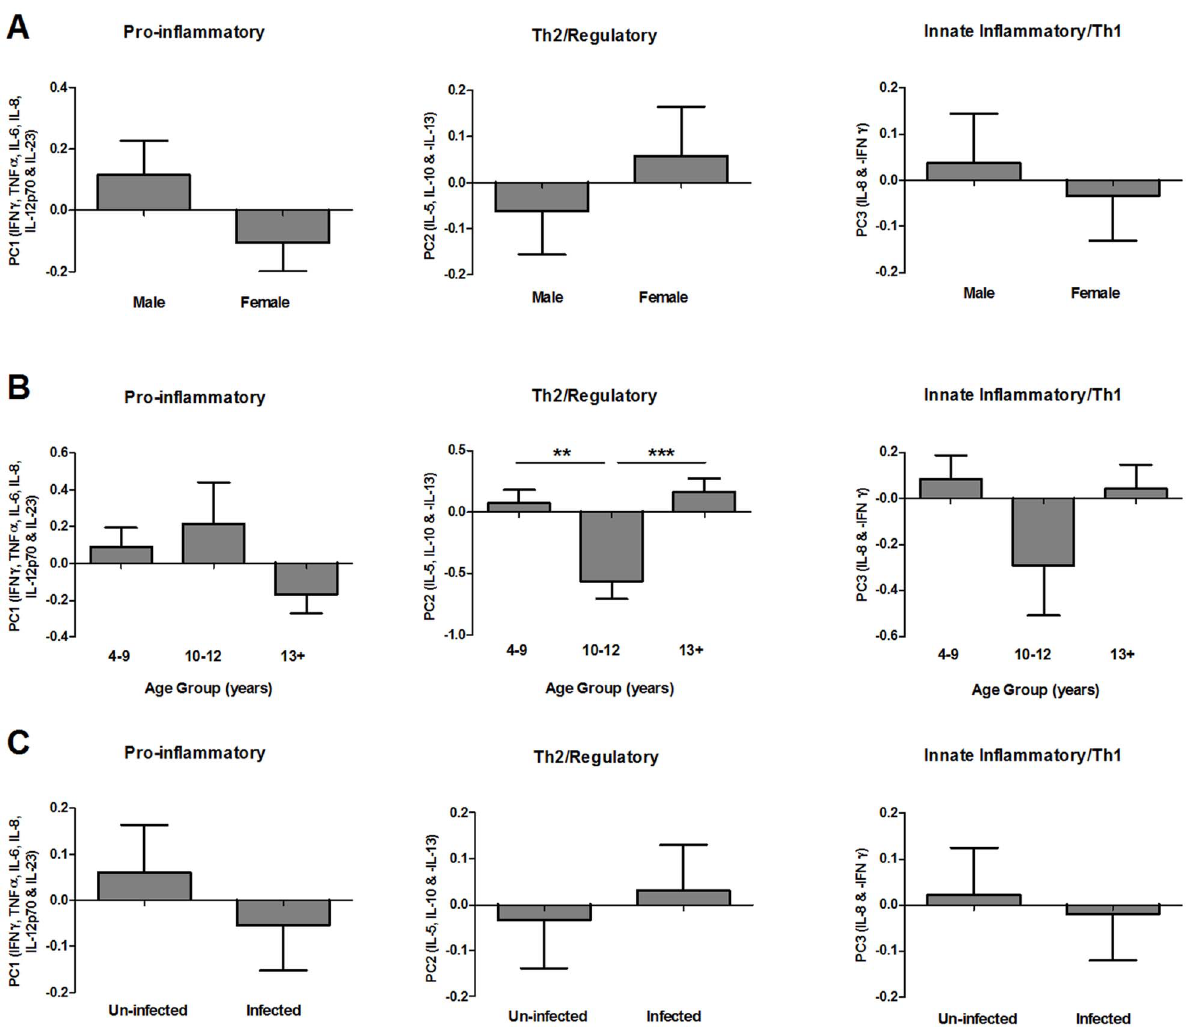
Figure 2. Distribution of pre-treatment GST-specific cytokine profiles by gender, age group and S.haematobium infection status. Mean principal component regression factor scores for pro-inflammatory (PC1), Th2/regulatory (PC2) and innate inflammatory/Th1 (PC3) cytokine profiles sub-divided by gender ( A ), age group ( B ) and schistosome infection status ( C ; un-infected=egg negative in all urine samples, infected=egg positive in one or more urine samples). Where ANOVA (sequential sums of squares accounting for variation in gender and age group before infection status) indicated that a factor significantly contributed to variation in cytokine profiles, pair-wise comparisons of PC scores were conducted via post- hoc Fisher’s least significant difference tests between the 3 age groups (n=195);**p , 0.01, ***p , 0.001. Error bars: standard error of the